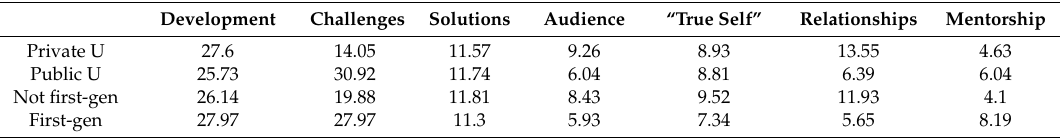
Table 4. Values expressed among student